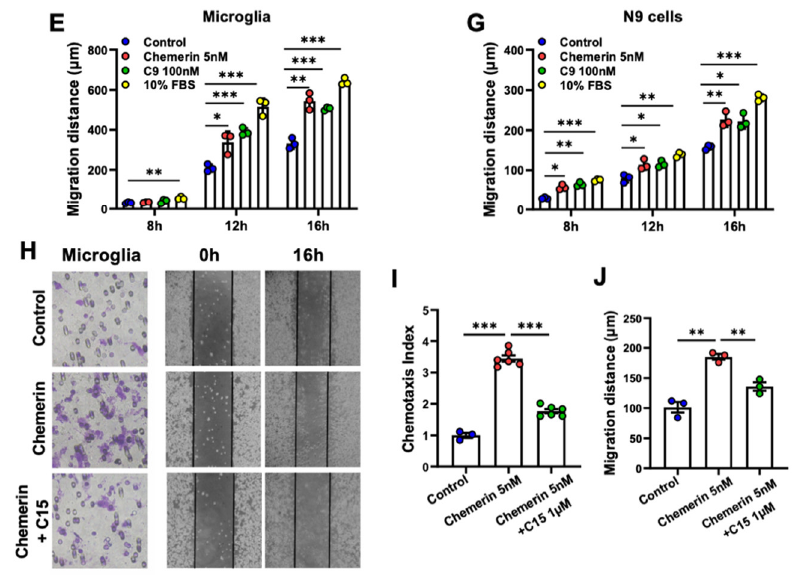
Figure 3. Chemerin/CMKLR1 axis promotes the migration of microglia in Boyden chamber migration and scratch-wound assay. ( A ) Primary cultures of microglia and murine microglial N9 cells were incubated for 12 h with chemerin (0.1–20 nM) or 10% FBS, and the migration of the cells was evaluated by 48-well chemotaxis chambers. Representative images of migrated cells on membrane filters are shown. ( B , C ) The Quantified data are shown. Magnification, ×400. Primary microglia and N9 cells were treated with chemerin (5 nM), C9 (100 nM), or 10% FBS; then, the migration of the cells was detected by scratch-wound assay. The microglia were photographed at 0 h, 8 h, 12 h, and 16 h. Representative images of migrated primary microglia and N9 cells are shown in ( D , F ), and quantified data are shown in ( E , G ), respectively. Magnification, × 100. ( H ) Primary microglia were incubated with chemerin (5 nM) with or without a 15 min pretreatment with C15 (1 µ M). After 16 h incubation, the migration of microglia was detected by 48-well chemotaxis chambers and scratch-wound assay. Magnification, × 400 and × 100, respectively. The quantified data were shown in ( I , J ). The results are expressed as the mean ± SEM from three separate experiments, each in at least triplicate. * p < 0.05, ** p < 0.01, *** p < 0.001. The authors apologize for any inconvenience caused and state that the scientific conclusions are unaffected. This correction was approved by the Academic Editor. The original publication has also been